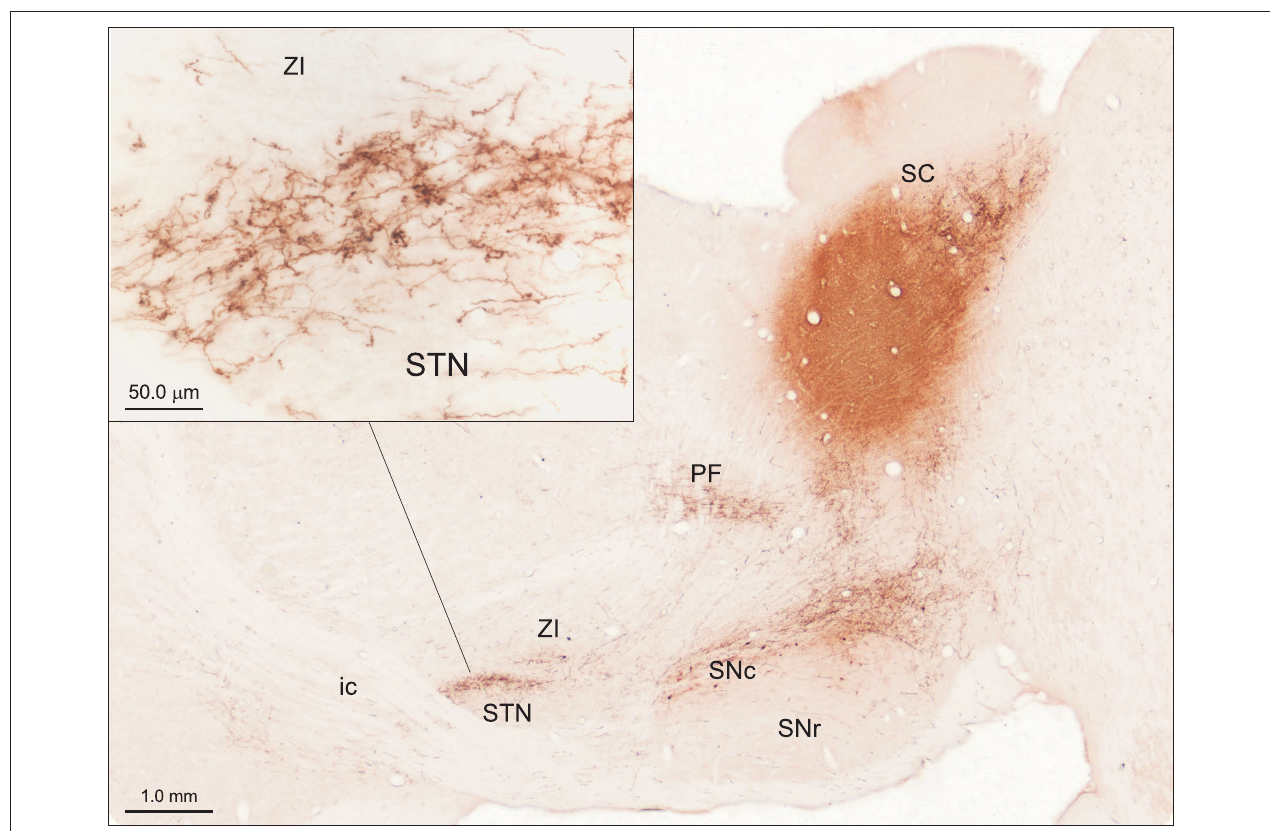
dense clusters of terminal boutons, presumably surrounding neuronal cell bodies in STN (see inset). The tecto-thalamic projection was also confirmed in this case with terminal labeling evident in the parafasicular thalamic nucleus (PF). ic, Internal capsule; SNr, substantia nigra pars reticulate; ZI, zona